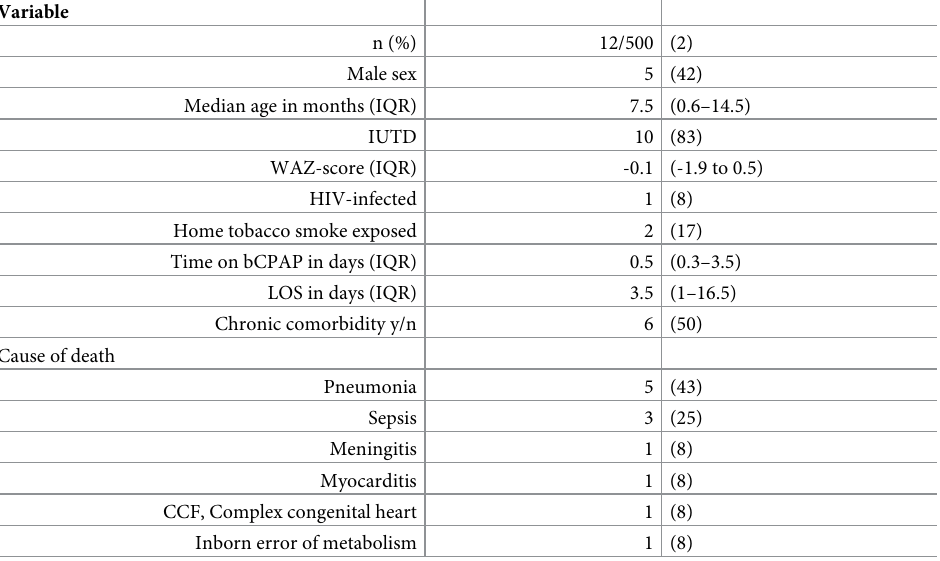
Table 5. Characteristics of the 12 children who